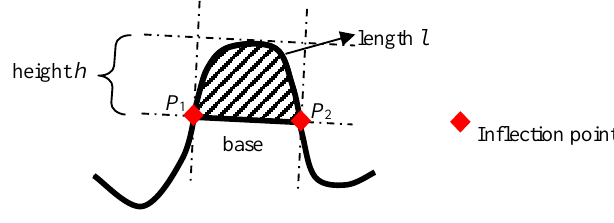
Figure 2. Measurements on a sinuosity suggested by Plazanet et al.